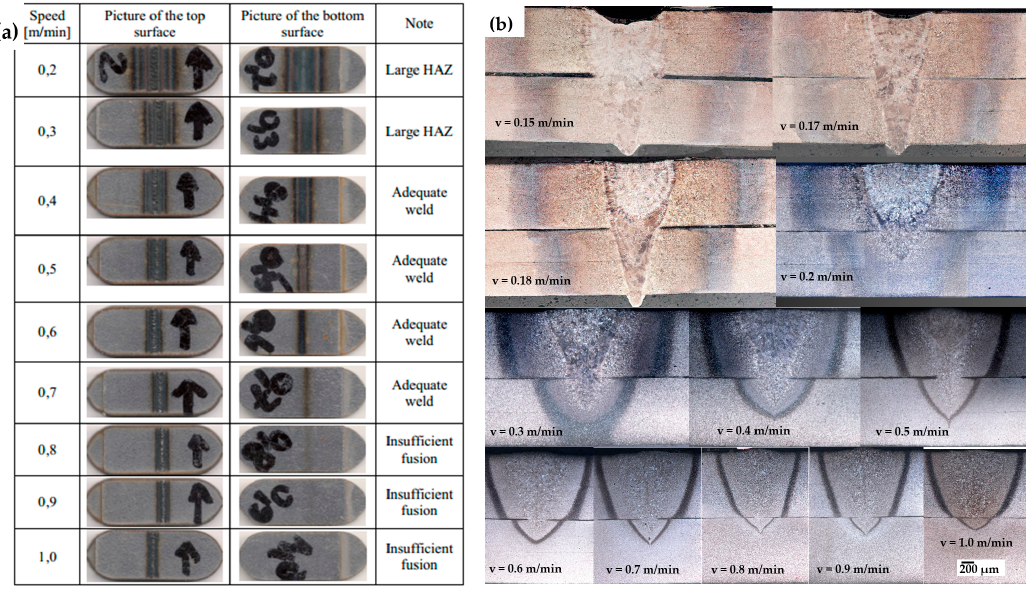
Figure 4. Macrographic images of laser welded Docol 1200M samples at constant 300 W laser power: ( a ) welding speed from 0.2 to 1.0 m / min for lap joints from upper and bottom side and ( b ) welding speed from 0.15 to 1.0 m / min for macro section showing the penetration depth.